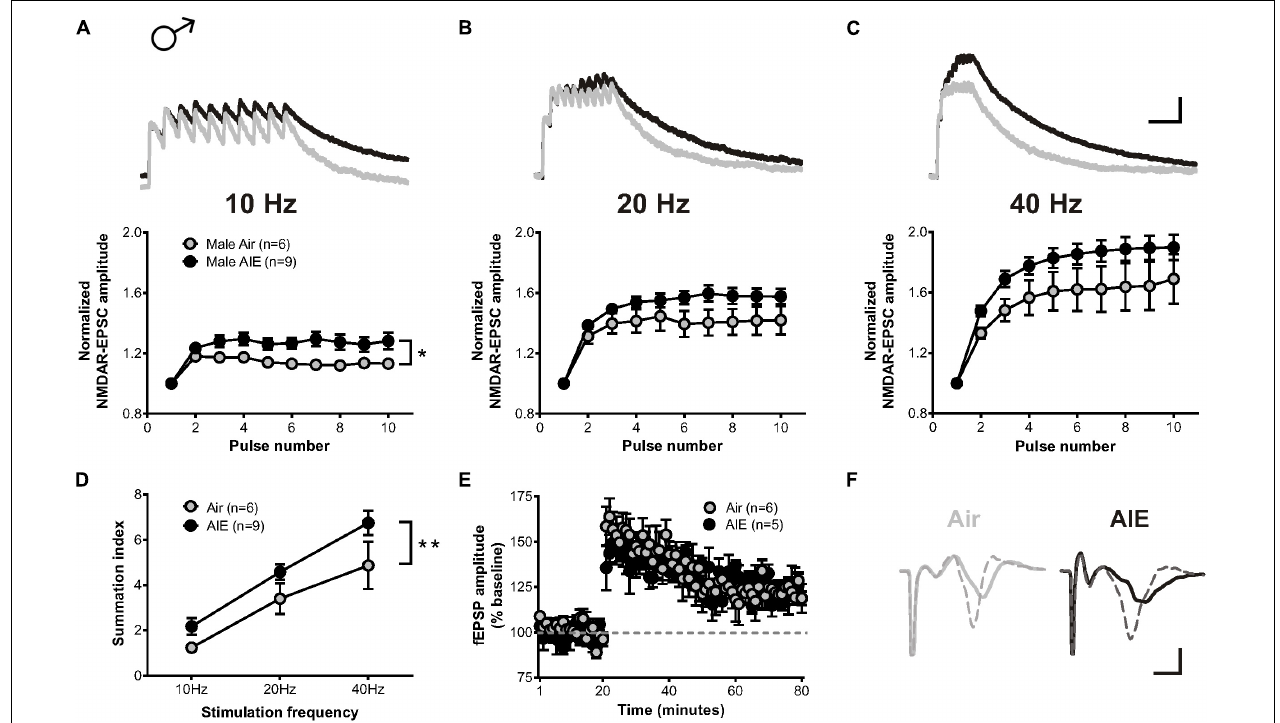
FIGURE 3 | Temporal summation of NMDAR-EPSCs and LTP following acute withdrawal from AIE in the male dlBNST. (A–C) Representative traces (top; Air gray, AIE black) and pooled data (bottom) demonstrating the ability of 10 stimulation pulses given at 10, 20, and 40 Hz to enhance the temporal summation of NMDAR-EPSCs during withdrawal from AIE; vertical scale bar = 200 pA, horizontal scale bar = 200 ms. Symbols indicate significant differences determined by a two-way repeated measures ANOVA; ∗ p < 0.05. (D) Plot of the summation index across different stimulation frequencies and treatments demonstrating a significant increase in temporal summation following AIE. A two-way ANOVA revealed a significant effect of treatment; ∗∗ p < 0.01. (E) Time course showing no difference in synaptic field potentials at baseline (20 min) and after the induction of LTP by high-frequency stimulation (two 1-s trains at 100 Hz) in the dlBNST of mice from Air- and AIE groups. (F) Representative traces recorded from Air (gray) and AIE (black) mice before (solid) and 60 min after (dashed) the high frequency tetanus; vertical scale bar = 0.3 mV, horizontal scale bar = 2 ms. All data points represent the mean ± SEM.